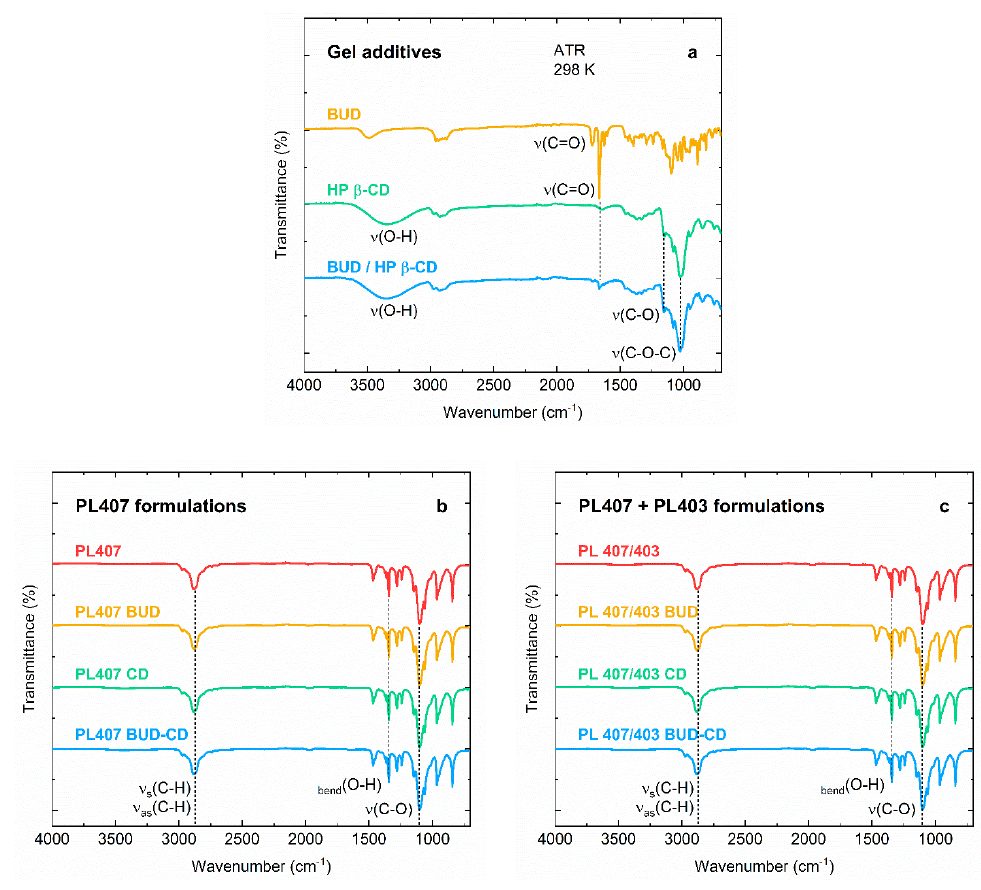
Figure 1. FTIR spectra of the ( a ) gel additives budesonide (BUD), hydroxypropyl β -ciclodextrin (HP- β -CD), and the BUD–HP- β -CD inclusion complex; ( b ) PL407-based formulations; ( c ) PL407/403-based formulations.